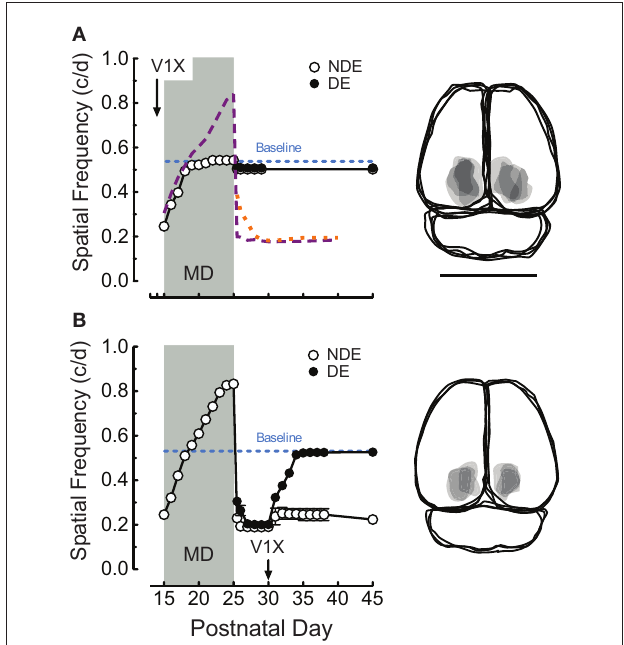
Figure 3 | Monocular deprivation and experience-enabled changes from P15 depend on visual cortex. (A) Bilateral V1 ablation on P14 prevented both enhancement, and loss-of-function generated by combined MD and OKT testing from P15 (orange, purple, and blue traces from Figure 1B ). Right panels are overlapping traces of lesions in groups. Bar = 1 cm. (B) Bilateral V1 ablation at P30 enabled thresholds through the previously deprived eye, but not the non-deprived eye,